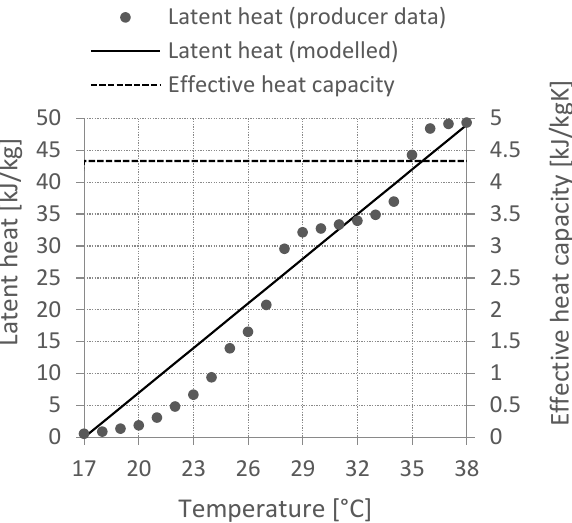
Figure 6. Values of the latent heat and effective heat capacity used in the calculations. Main assumptions for the simulation: